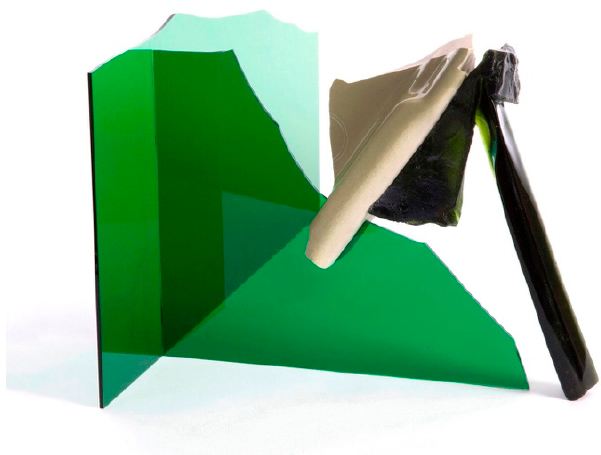
Figure 3. Matthias. 2014. Anatomical Deconstruction IX .